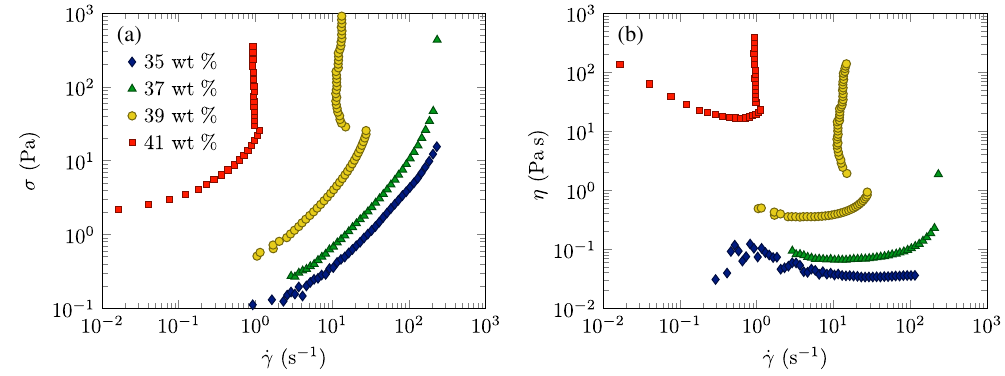
FIG. 17. Flow curves of dense cornstarch suspensions at various weight fractions and prepared as described in Appendix 1. (a) Shear stress σ and (b) viscosity η as a function of the shear rate _ γ . Data obtained by ramping up the imposed stress σ with at least 5 s per point in the parallel-plate geometry described in Appendix